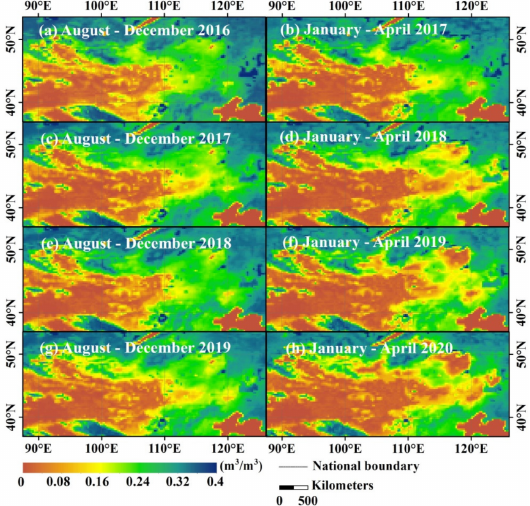
Figure 7. Spatial distribution of volumetric soil water parameters over the MP and surrounding